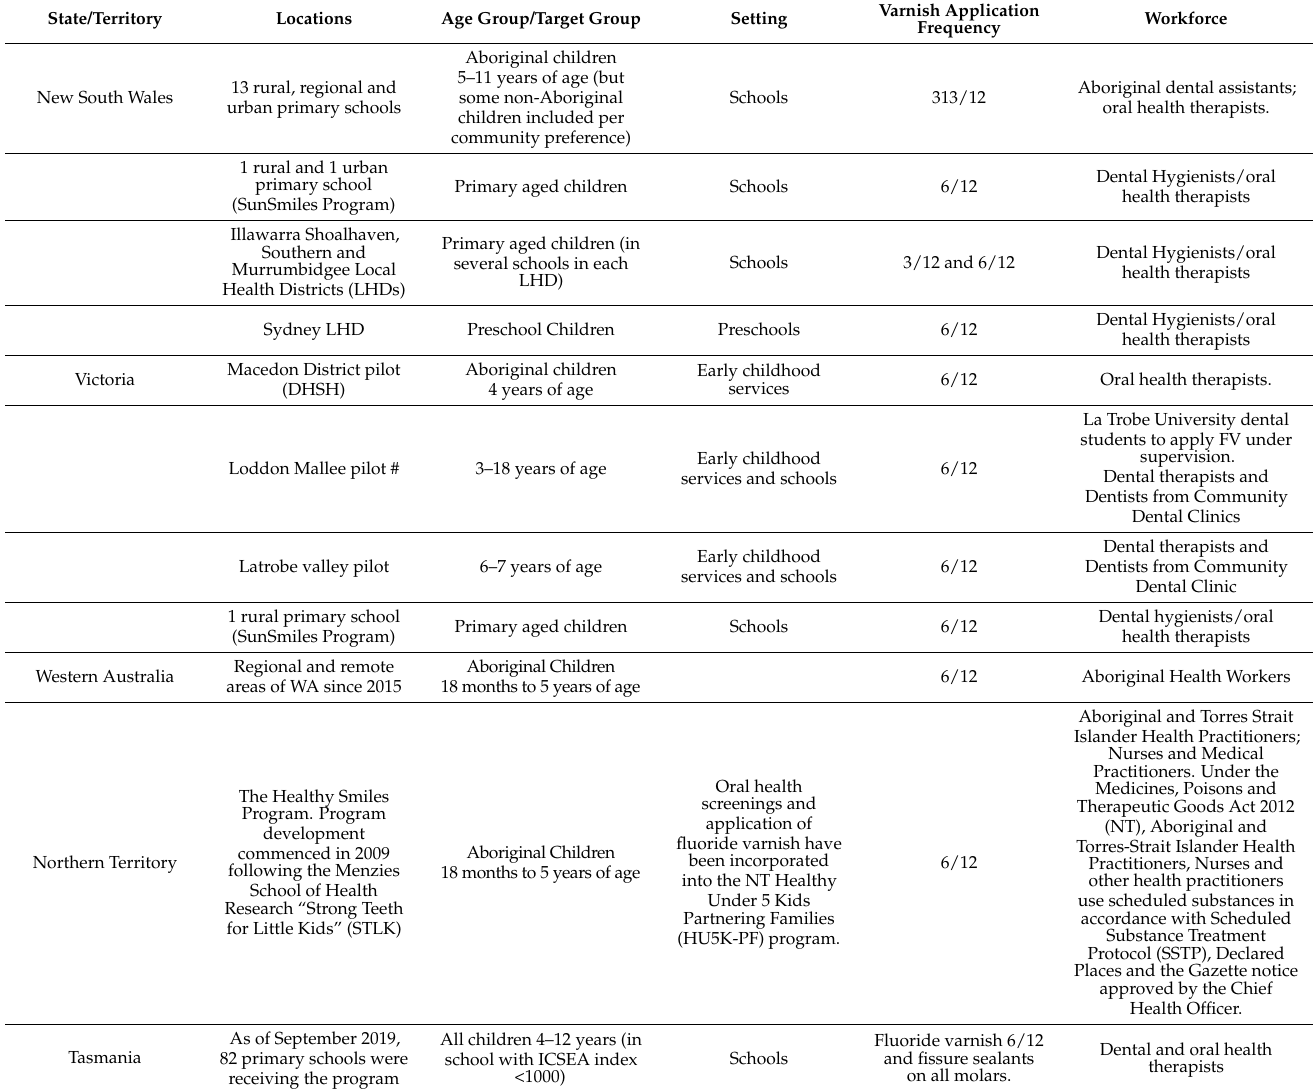
Table 4. Fluoride varnish programs by Australian State and